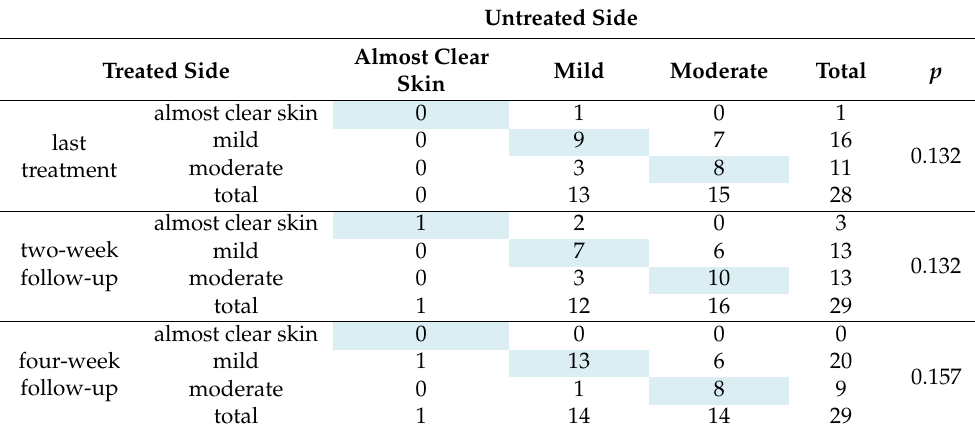
Table 5. Comparison of the Investigator Global Assessment between the treated and the untreated side of the